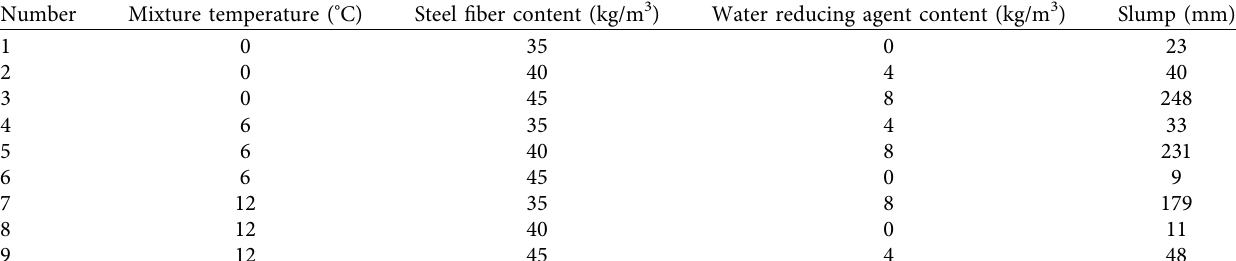
Table 1: The effect of concrete mixture temperature, steel fiber, and water reducing agent on slump.